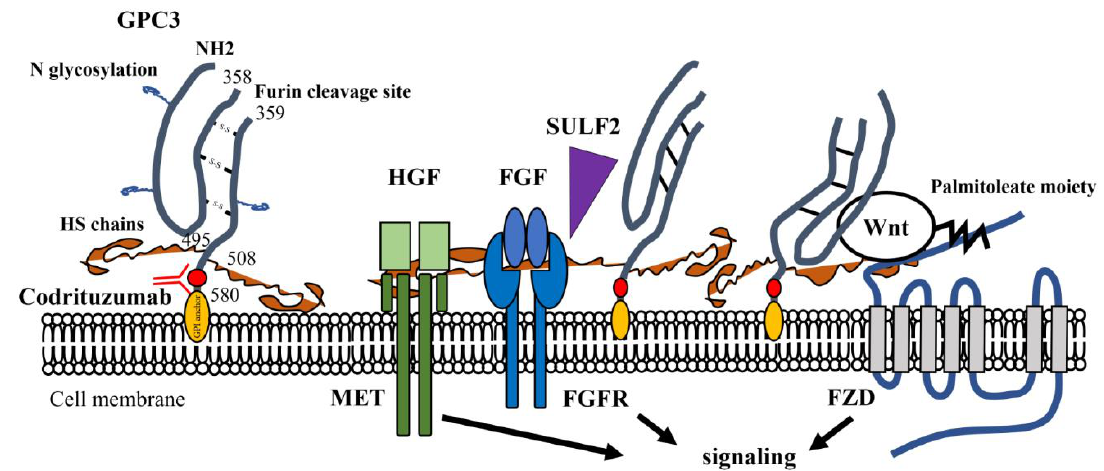
Figure 1. Structure of the glypican-3 (GPC3) molecule and possible involvement GPC3 in progression of HCC. The core protein consists of 580 amino acids. Two heparan sulfate (HS) side chains are attached near the C-terminal portion. Codrituzumab (GC33) recognizes the epitope near the glycosyl-phosphatidylinositol (GPI) anchor. Growth factors such as Wnt, fibroblast growth factor (FGF), and hepatocyte growth factor (HGF) can be complexed with HS side chains. In Wnt signaling, GPC3 core protein functions with Frizzled receptor (FZD) as a co-receptor. Sulfatase 2 (SULF2) is known to release FGF to transduce signals through its specific receptor. MET: receptor of HGF; FGFR: fibroblast growth factor receptor; FZD: Frizzled receptor.